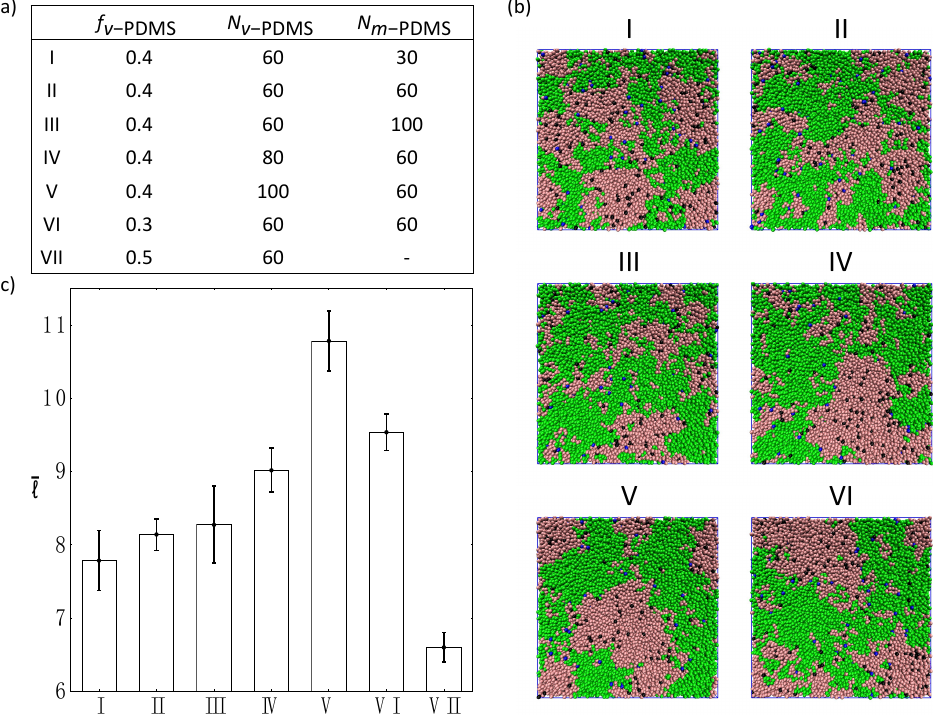
Figure 5. Ternary blends containing PHMS ( f PHMS = 0.5 and N PHMS = 30), m -PDMS, and v -PDMS. ( a ) Compositions for cases I–VII. ( b ) Equilibrium snapshots for cases I–VI. ( c ) The equilibrium characteristic length scale, l , for cases I–VII.